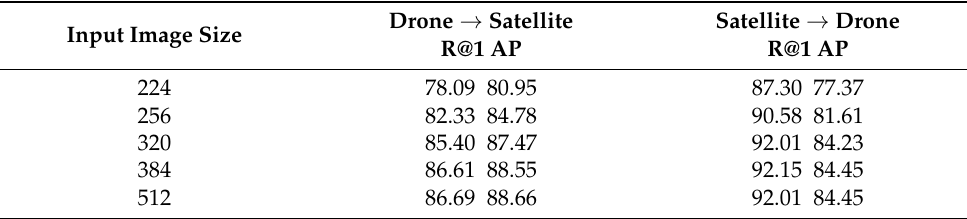
Table 6. Results of ablation experiments of different input sizes of images during training and testing.